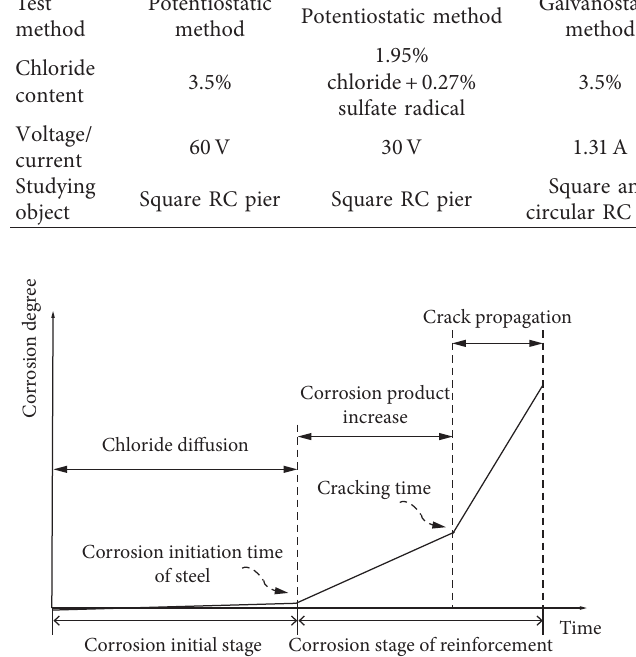
Figure 1: Chloride-induced degradation model of